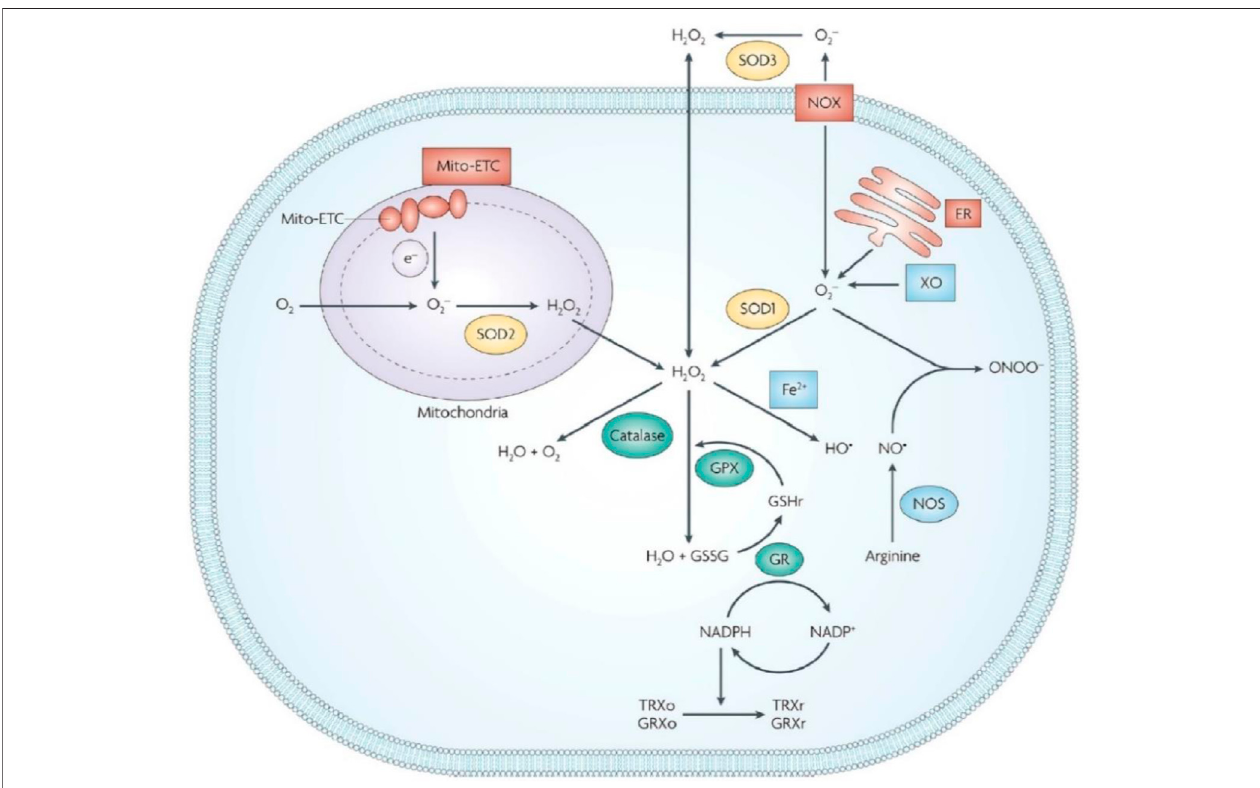
FIGURE 1 | ROS-induced cellular redox homeostasis. Endogenous and exogenous pathway have close relationship with intracellular ROS levels. In order to maintain ROS at a normal level for organism well-being, ROS-ablating enzymes are available in cells to avoid oxidative stress. GR, glutathione reductase; GPX, glutathione peroxidase; GRXo, oxidized glutaredoxin; GRXr, reduced glutaredoxin; TRXo, oxidized thioredoxin; TRXr, reduced thioredoxin; GSHr, reduced glutathione; GSSG, oxidized glutathione. Reproduced from Wu et al. (2019a) with permission from the American Chemical Society.